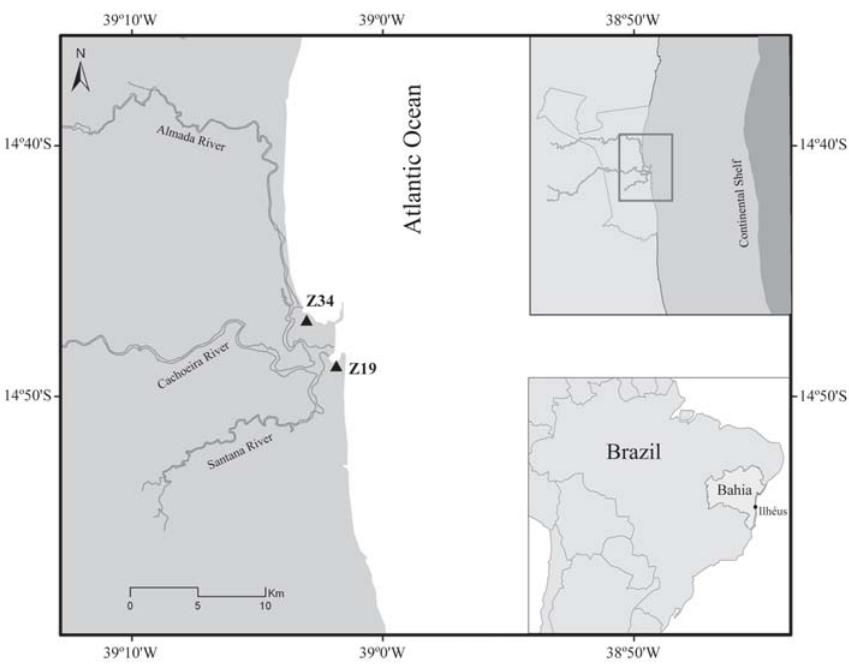
Fig. 1. Map of Bahia State, Brazil, indicating the location of the fishing colonies Z19 and Z34, continental shelf and the municipality of